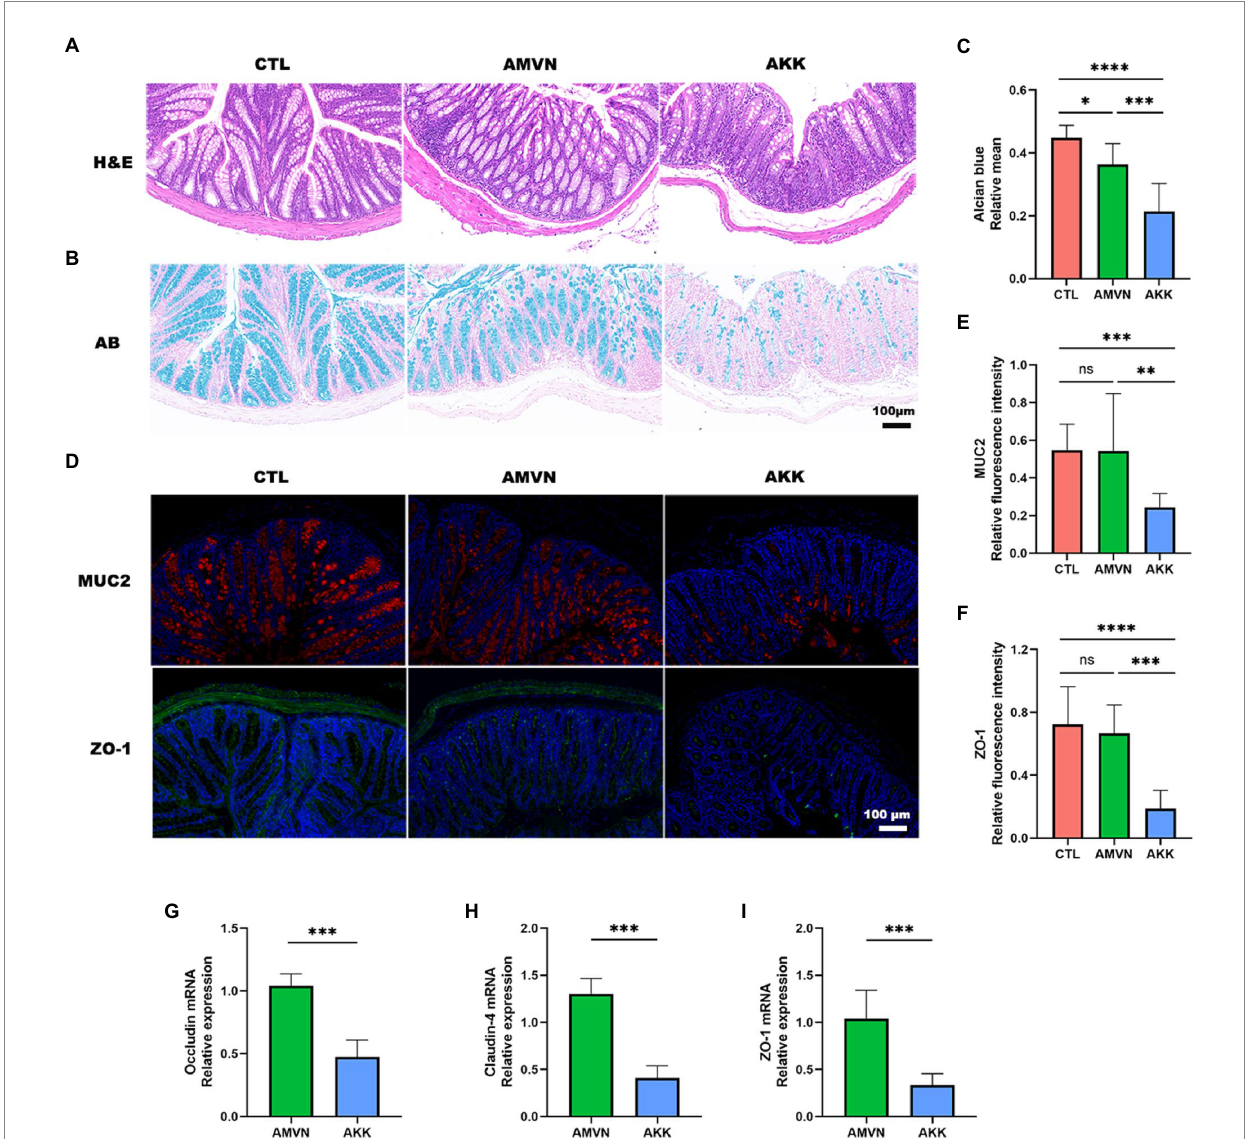
FIGURE 5 Disruption of the intestinal barrier by excess colonization of Akkermansia muciniphila. (A) H&E staining of colonic tissues. Scale bar, 100 μ m. (B) Alcian blue staining of colonic tissues. Scale bar, 100 μ m. (C) Quantitative analysis of Alcian blue staining; relative mean. (D) Immunofluorescence staining of colon tissues for MUC2 (red) and ZO-1 (green). DAPI (blue) was used to stain nuclei. Scale bar, 100 μ m. Quantitative analysis of MUC2 (E) and ZO-1 (F) relative fluorescence intensity. The relative mRNA expression of occludin (G) , claudin-4 (H) , and ZO-1 (I) in the intestinal tissue in the AKK and AMVN groups. Data are mean ± SEM; n ≥ 3, “ns,” not significant, * p < 0.05, ** p < 0.005, *** p < 0.0005, and **** p <